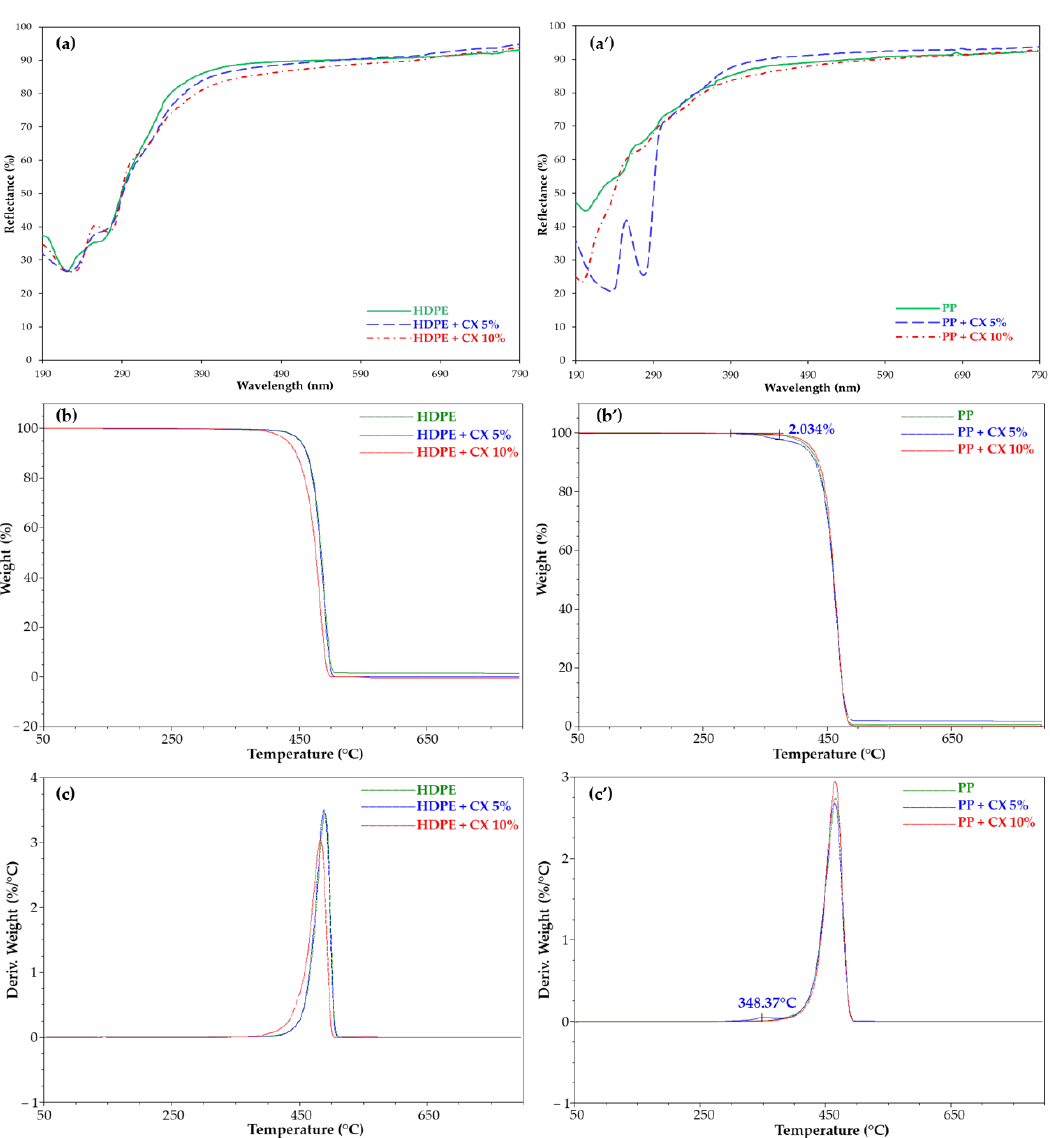
Figure 7. Reflectance (%) spectra, TGA, and DTG of ( a – c ) HDPE and ( a’ – c’ ) PP films, empty (green line) and embedded with CX (blue and red lines).